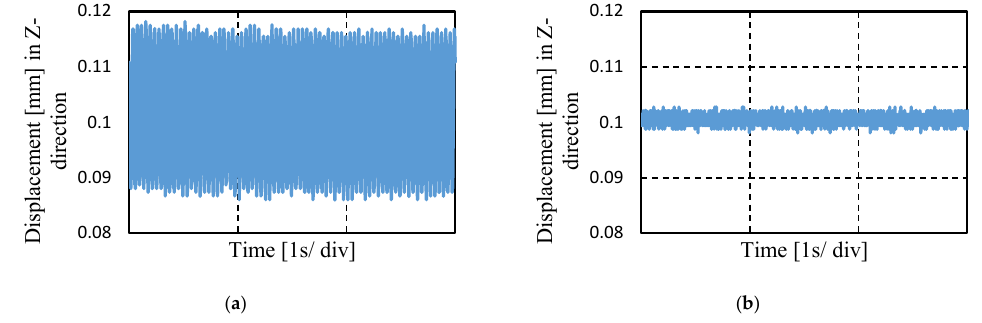
Figure 8. Effect of balancing the forces on floator position in Z ‐ direction: ( a ) vibration occurs due to unbalanced force; ( b ) vibration reduced by assigning proper gains of EMs.